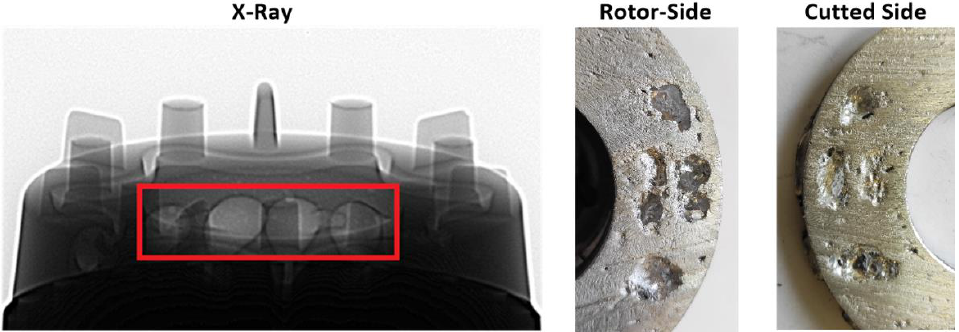
Figure 26. Outputs of a rotor R2 (defect in end-ring).